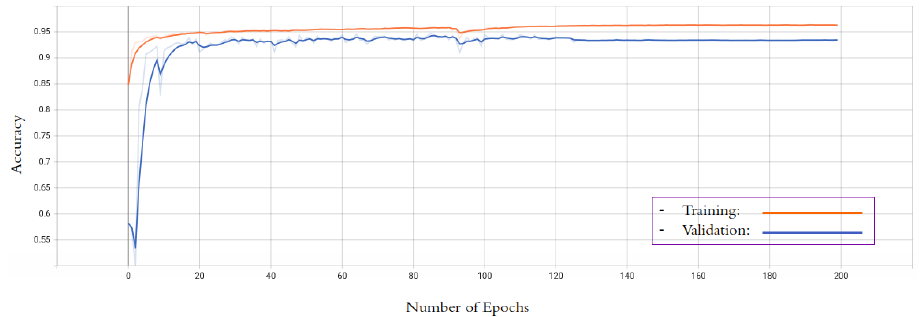
Figure 7. The training and testing processes evaluated by the accuracy metric.